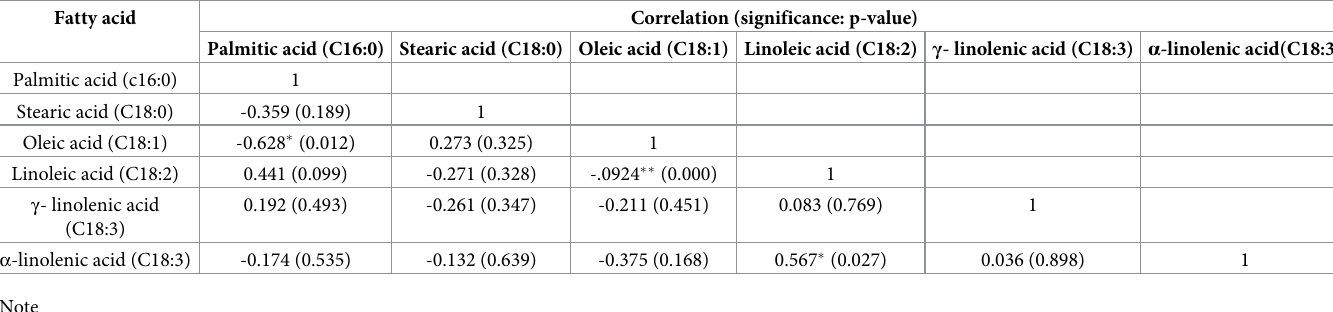
Table 4. Correlations among saturated and unsaturated fatty acids.